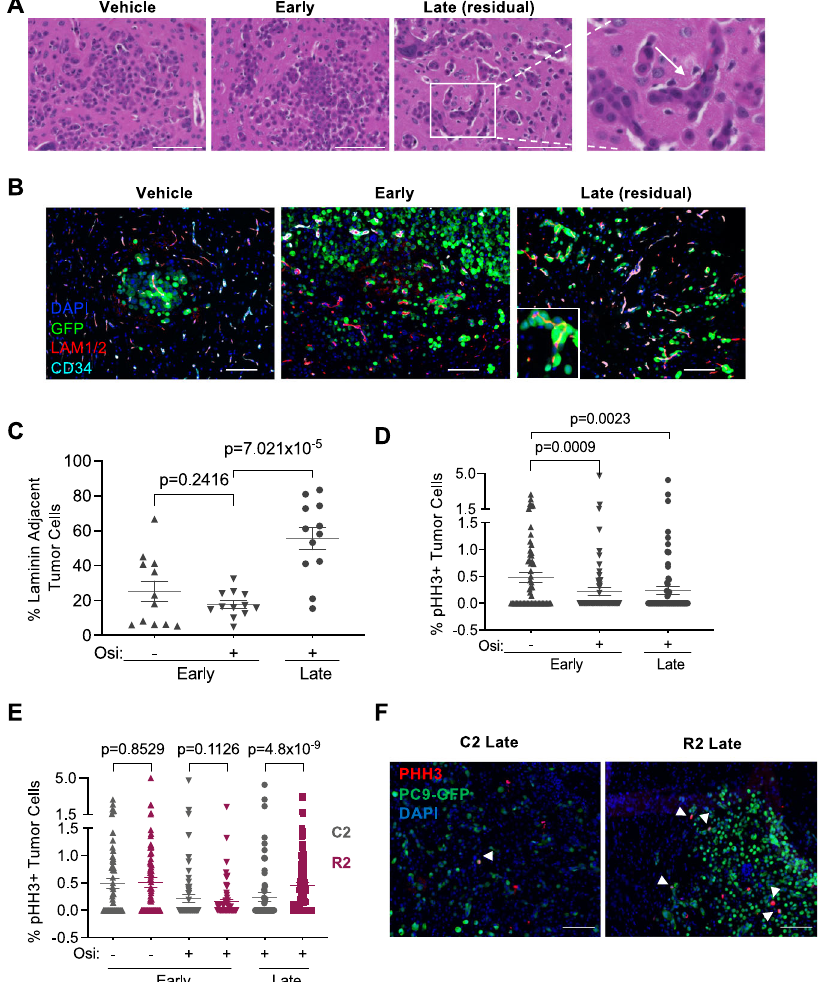
Fig. 5 | Re-modeling and co-option of the brain vasculature correlates with residual disease. A Representative images of hematoxylin-eosin- (H&E-) stained brain tissue sections from mice with C2 brain metastases treated with vehicle or osimertinib and collected at “ Early ” or “ Late ” timepoints as in Fig. 4A. Scale bar indicates 100 μ m. Inset is an expanded view of Late sample. White arrow indicates brain perivascular residual tumor cells in osimertinib-treated animal. Representa- tive images from Vehicle (4 tumors/2 mice), Early (4 tumors/2 mice), Late residual (8 tumors/3 mice). B Representative images of C2 brain metastasis tissue (N=12 images from 3 mice) collected as in A and subjected to immuno fl uorescent (IF) staining for nuclei (DAPI; blue), tumor cells (GFP; green), laminin (red), and vas- culature (CD34; turquoise). Scale bar indicates 100 μ m. C The number of GFP- positive C2 tumor cells adjacent to laminin-positive micro-vessels were manually